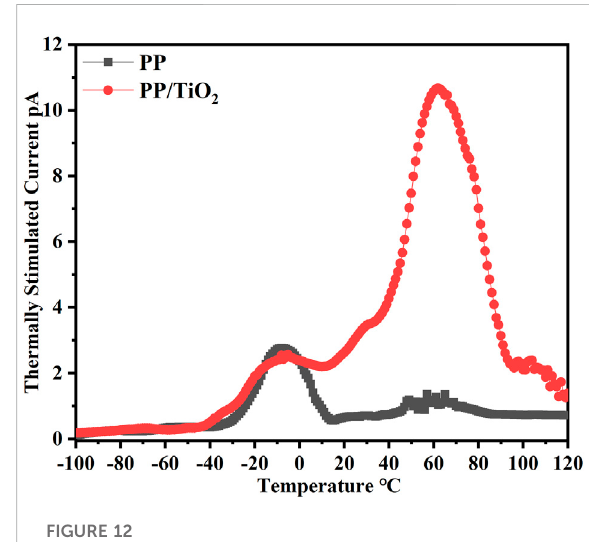
FIGURE 12 TSC results of PP and PP/TiO 2 nanocomposites.